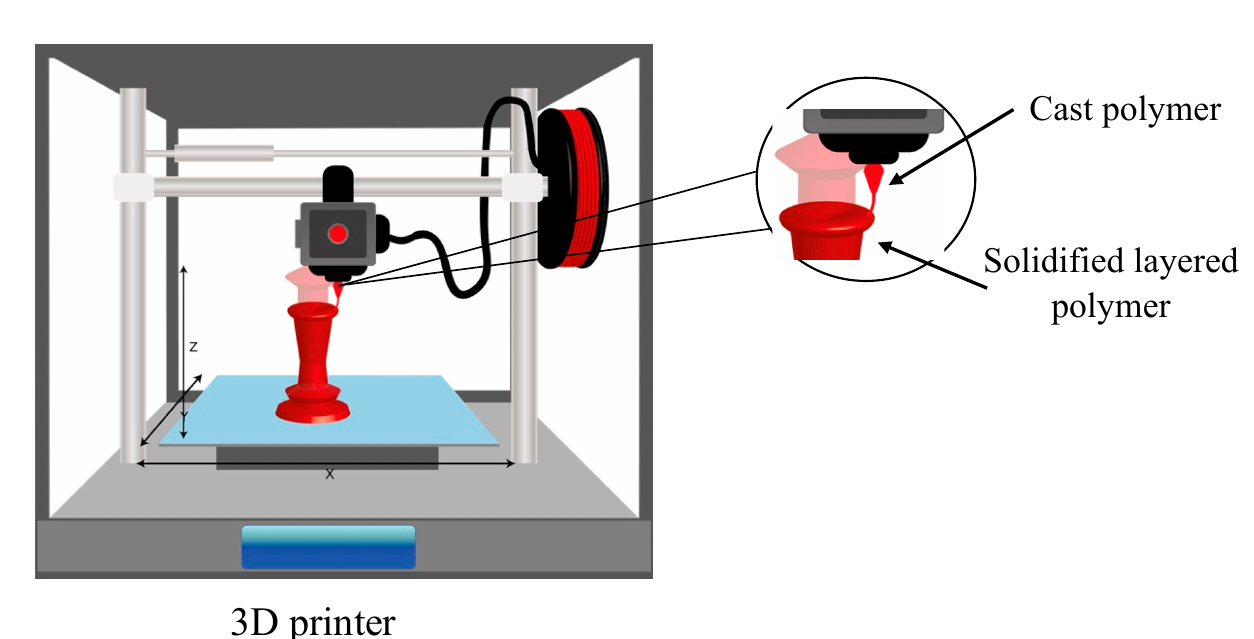
Figure 4. Schematic diagram of the 3D printing method.